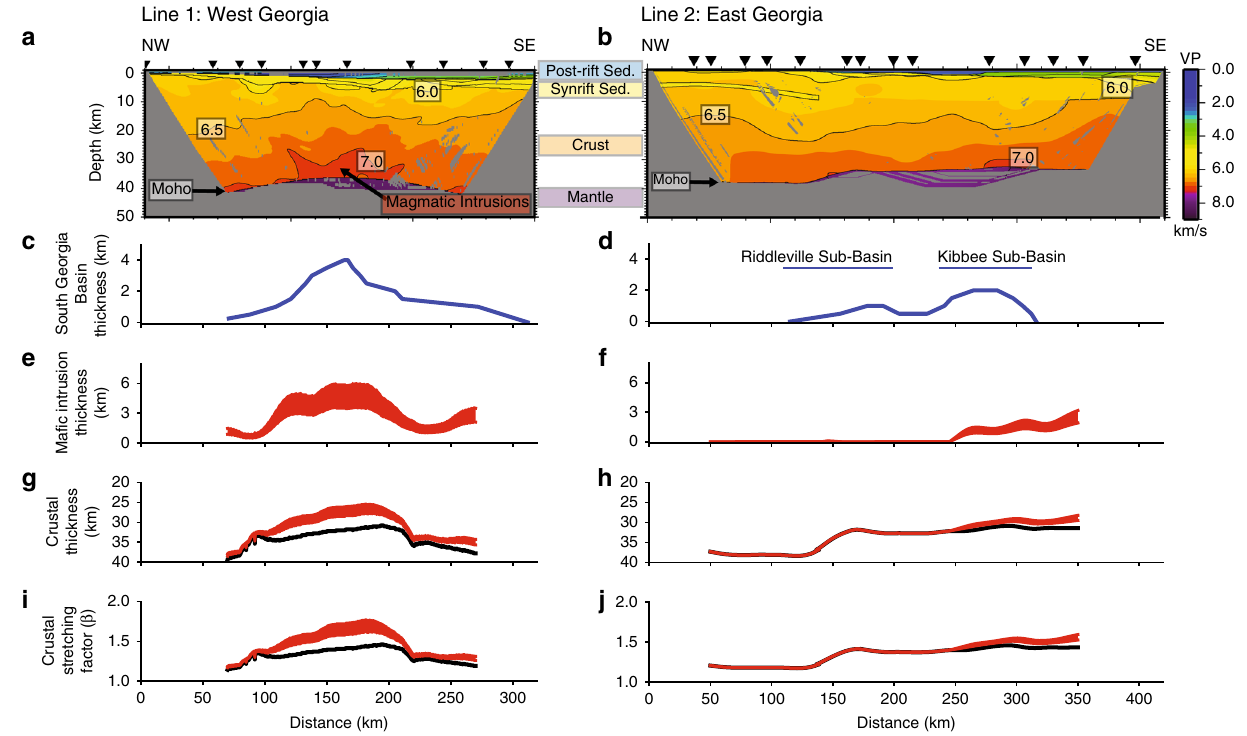
Fig. 2 Crustal stretching and magmatism inferred from velocity models. a, b V P models with 0.5 kms − 1 contour interval for Line 1 ( a ) and Line 2 ( b ). Black triangles indicate shot locations. Areas with no ray coverage are masked in gray. c , d South Georgia Basin thickness with labels for sub-basins beneath Line 2 49 . e , f Range of possible thicknesses of lower crustal ma fi c intrusions assuming ma fi c intrusion velocities from 7.2 km s − 1 to 7.5 km s − 1 . g , h Observed crustal thickness (black) and crustal thickness without estimated lower crustal ma fi c intrusions ( e , f ). i , j Crustal stretching estimates assuming an initial crustal thickness of 45 km (black) 55 ; red curves show crustal thickness and crustal stretching factor with ma fi c intrusions ( e , f )